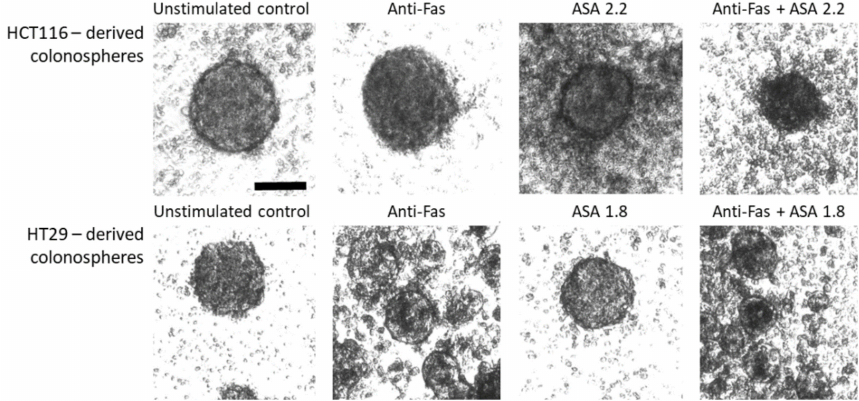
Figure 2. Morphology of colonospheres. Representative colonospheres were derived from HCT116 and HT29 cells following 10-day incubation with agonistic anti-Fas antibody (200 ng/mL) and/or aspirin (ASA) (2.2 mM or 1.8 mM for HCT116 or HT29, respectively). Scale bar, 100 µ